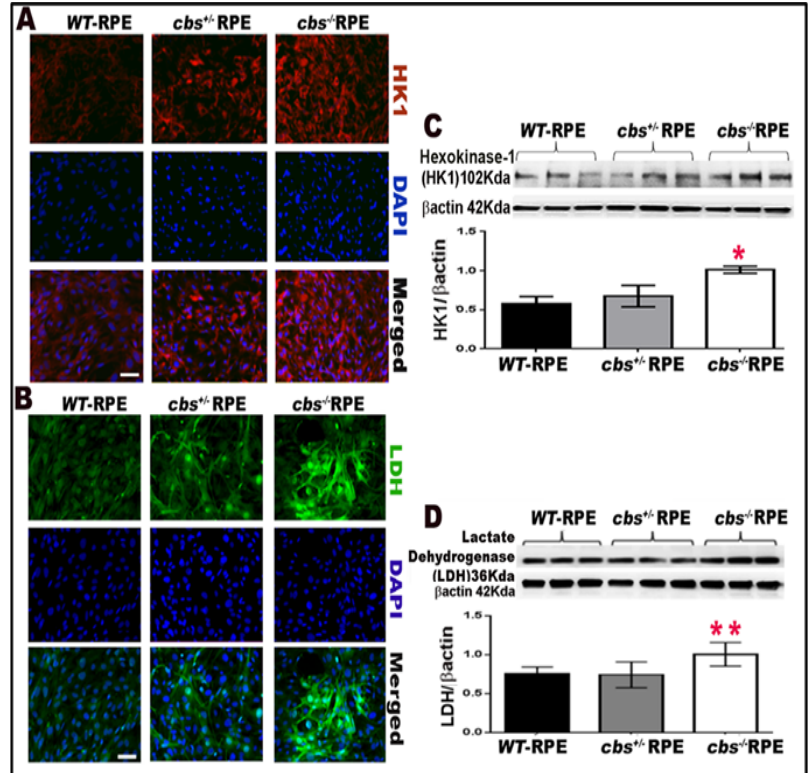
Figure 3. Homocysteine promotes glycolysis by activating glycolytic enzymes. ( A ) Immunofluorescence staining for HK-1 (red) and nuclear staining (DAPI, blue) for primary RPE cells isolated from cbs +/+ cbs +/ − , and cbs − / − mice. ( B ) Immunofluorescence staining for LDH (green) and nuclear staining (DAPI, blue) for RPE cells isolated from cbs +/+ andd cbs +/ − mice. ( C ) Western blot of HK-1 expression in primary RPE cells isolated from mice model of elevated Hcy (wild-type cbs +/+ , cbs +/ − , and cbs − / − ) showing a significant increase in HK-1 expression in mice with marked HHcy. β actin was used as loading control. ( D ) Western blot of LDH expression in primary RPE cells isolated from mice model of elevated Hcy (wild-type cbs +/+ , cbs +/ − , and cbs − / − ) showing a significant increase in LDH expression in mice with marked HHcy. β actin was used as a loading control. Scale bar: 50 μ m. * p < 0.05, ** p < 0.01 compared to WT and cbs +/ − RPE.